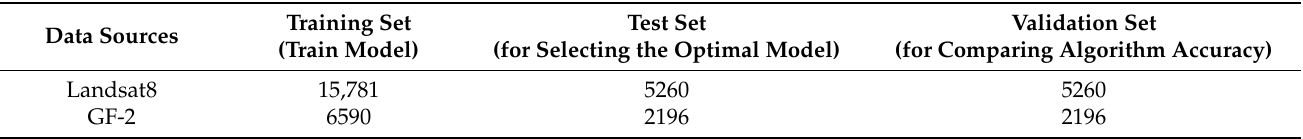
Table 1. The proportion between training data and test data.